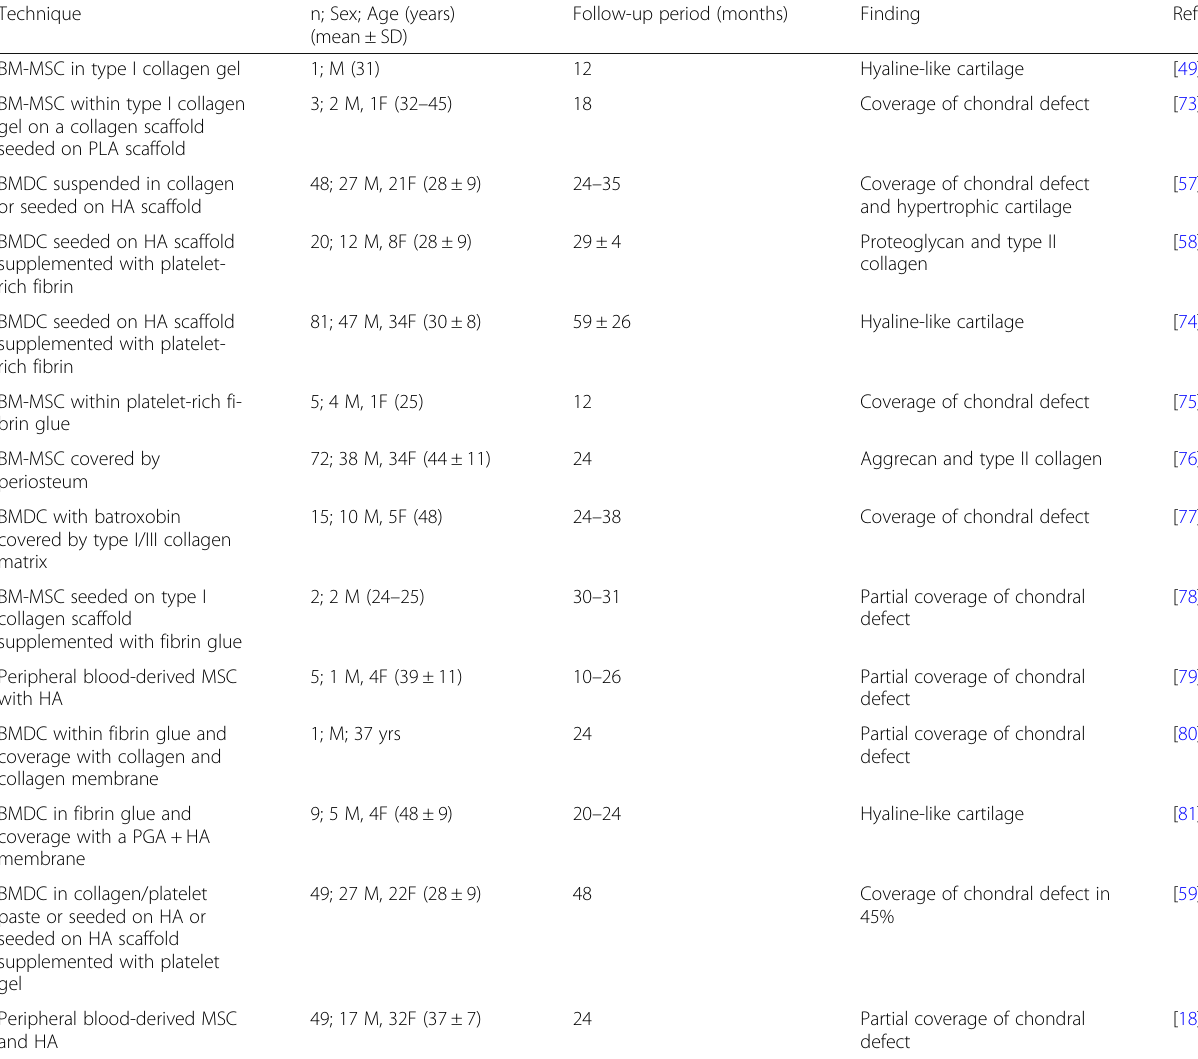
Table 2 Application of MSC seeded onto different types of scaffolds into patients with damaged articular cartilage Technique n; Sex; Age (years) Follow-up period (months) Finding (mean ± SD)